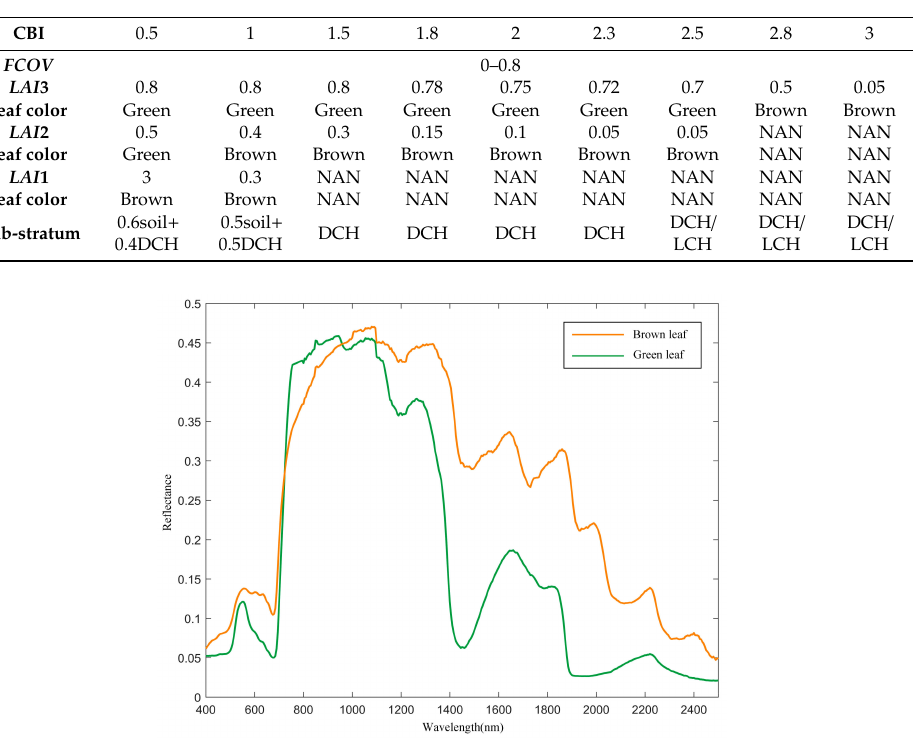
Table 3. Combination of parameters used as inputs in the coupled RTM for simulating the reflectance corresponding to di ff erent CBI values. To improve the e ffi ciency of model execution and alleviate the ill-posed problem, only the parameters sensitive to burn severity inversion were used to construct Look Up Tables (LUTs).